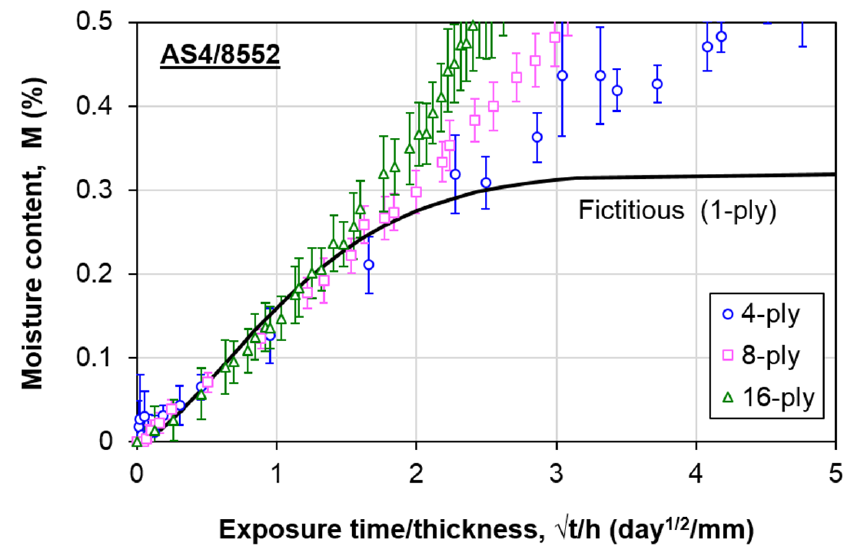
Figure 5. Estimation of the initiation of non-Fickian behavior.